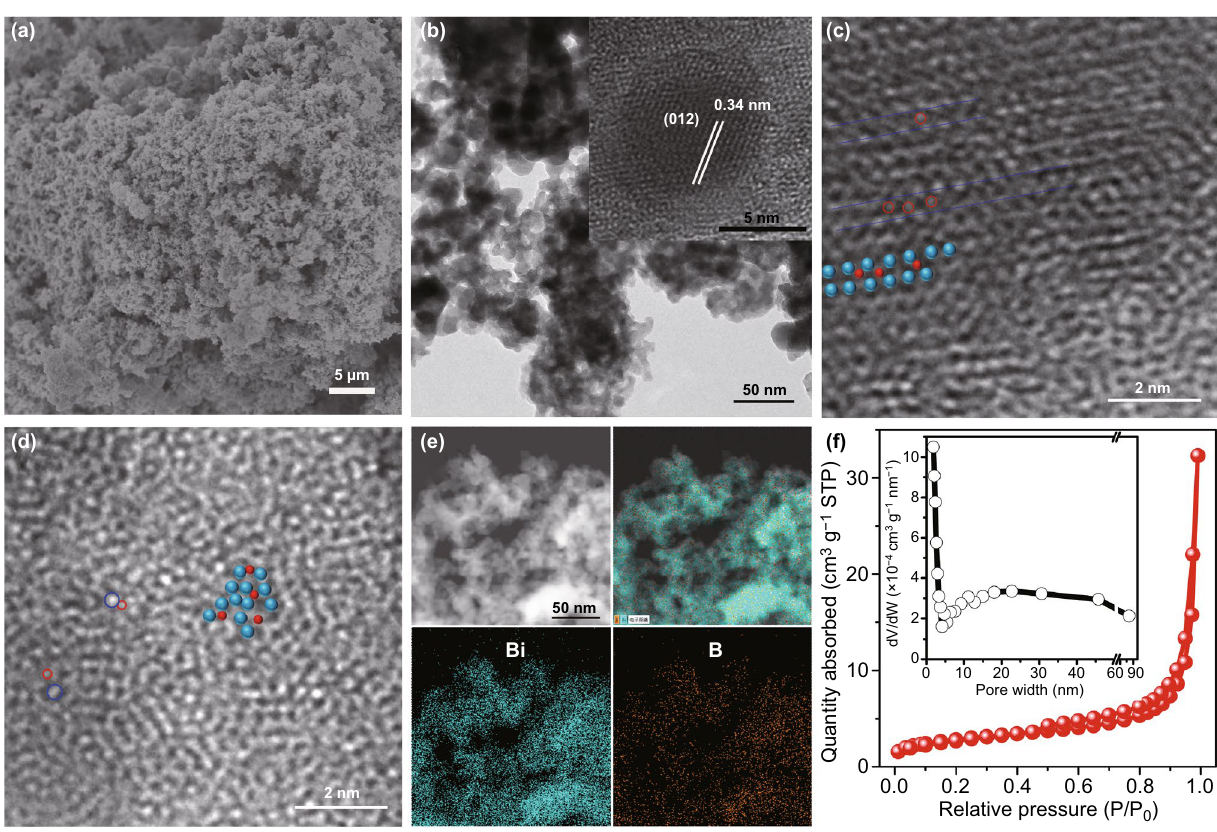
Fig. 1 a SEM b TEM, c , d HRTEM images (the blue and red balls represent the Bi and B atoms, respectively), e HAADF‑STEM images and the corresponding STEM‑EDS element mappings, f N 2 adsorption–desorption isotherms and the corresponding pore size distribution curve for Bi‑B2